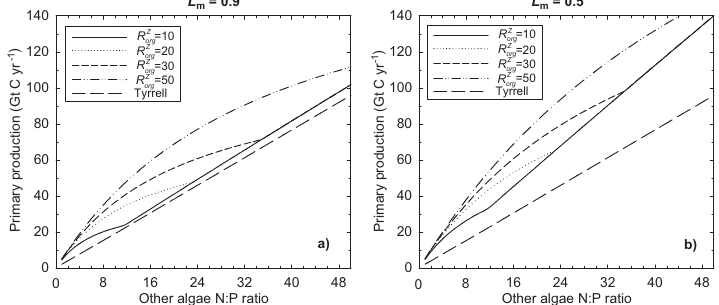
Fig. 6. Global primary production plotted against the ratio of nitrogen to phosphorus (N:P) in non-fixers pool using two different maximum accumulation efficiencies in herbivores ( L m =0.9 or L m =0.5), and four different N:P ratios in herbivores ( R Z org ) . The assimilation efficiency of nitrogen ( β N ) and phosphorus ( β P ) were set at 0.69 and 0.80, respectively. Solutions for the Tyrell’s model without herbivores are also 1 1 shown (dashed line).